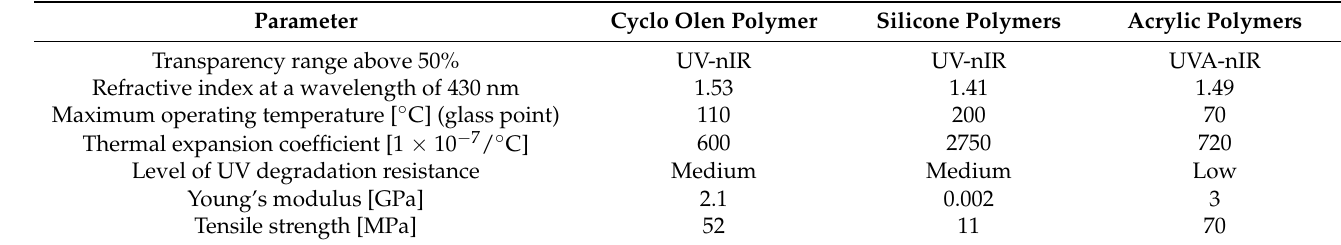
Table 2. Basic parameters of transparent polymers, based on